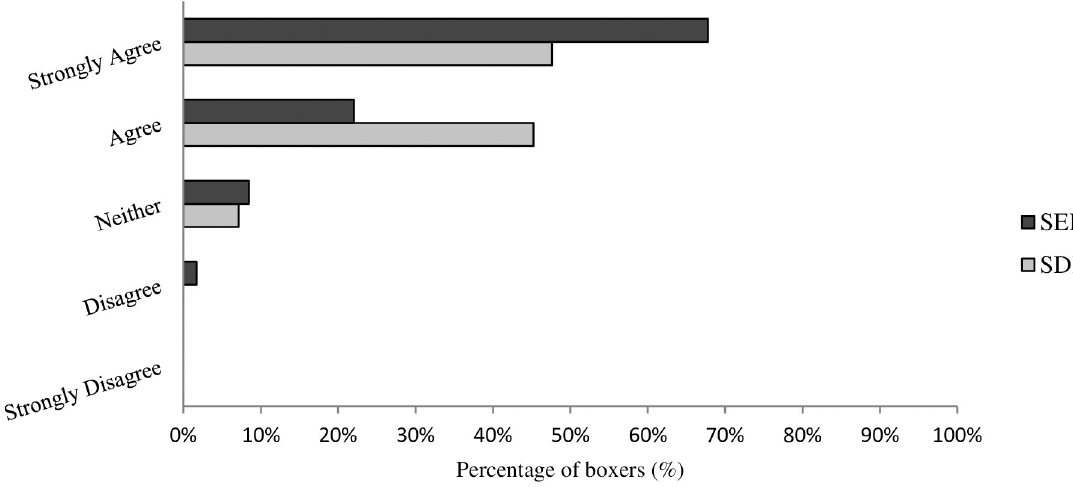
Fig 4. Likert scale scores on whether scientific support benefits boxing